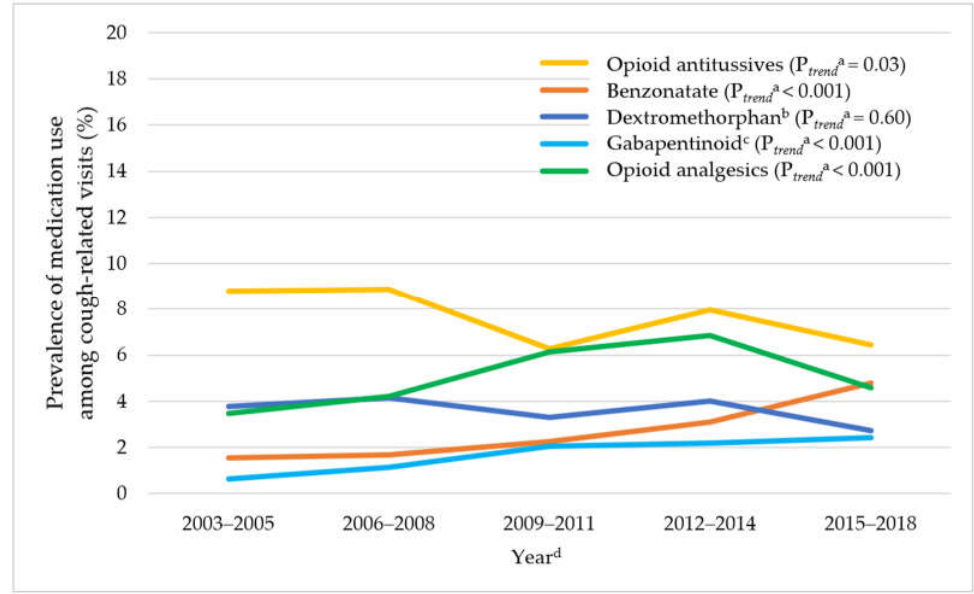
Figure 2. Trends in medication use among adult cough-related visits in office-based ambulatory care setting: 2003–2018 NAMCS. Abbreviations: NAMCS: National Ambulatory Medical Care Survey; NCHS: National Center for Health Statistics. a P trend were adjusted for age, sex, race, and payment source. b Dextromethorphan indicates dextromethorphan-containing antitussives. c The weighted-estimate for gabapentinoid in 2003–2005 is unreliable based on NCHS’s recommendation. d The weighted-estimate of the denominator (i.e., adult cough-related office-based visits) for each time period in NAMCS is 183.7 million, 171.9 million, 179.7 million, 152.8 million, and 131.8 million